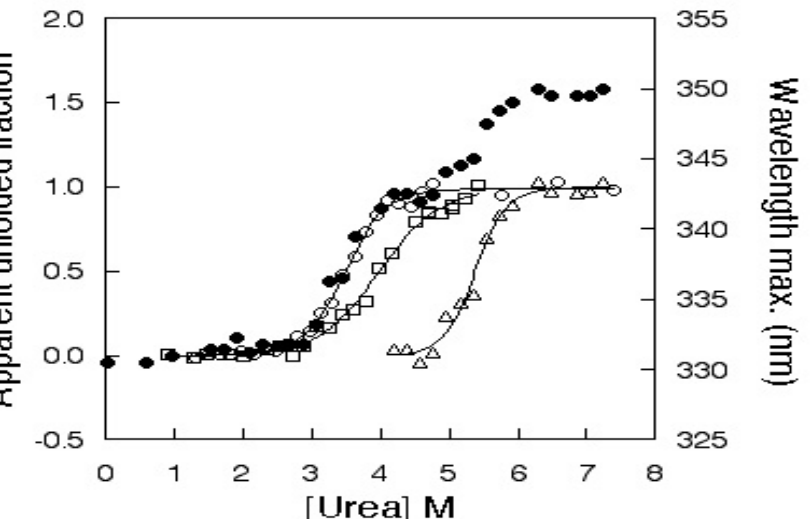
FIGURE 1. Urea denaturation of scFv at pH 7.0, followed by fluorescence intensity (o), far-UV CD ( (cid:31)) and wavelength of maximal fluorescence emission ( • ). The wavelength red-shift at higher urea concentration is additionally represented for better comparison ( ∆